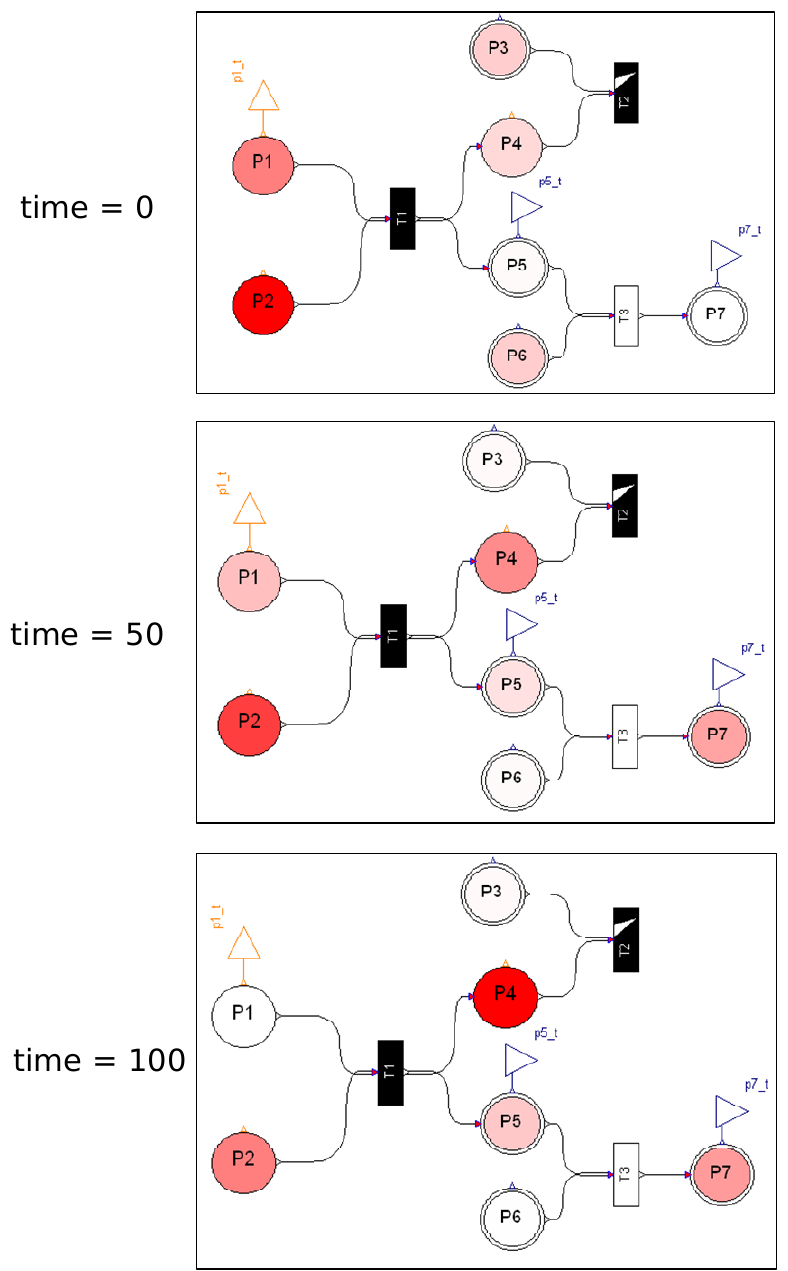
Figure 20: Animation of a Petri Net in Dymola; the Token distribution of the Petri Net example, top: at the beginning of the simulation, middle: after a simulation of 50 time units, bot m: after a simulation of 100 time units; the degree of redness corresponds to the Token numbers, i.e red Place has many Tokens and a white Place is